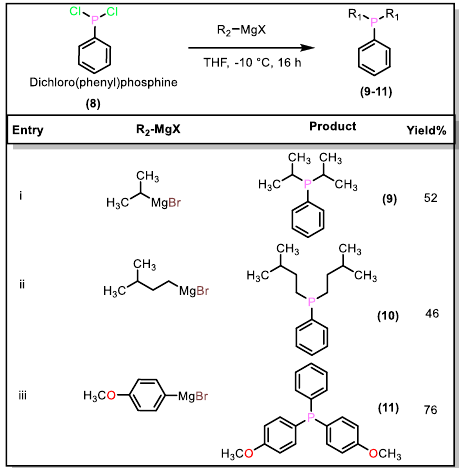
Figure 2. Synthesis of mixed arylalkyl and triaryl phosphines starting from dichloro- phenylphosphine.